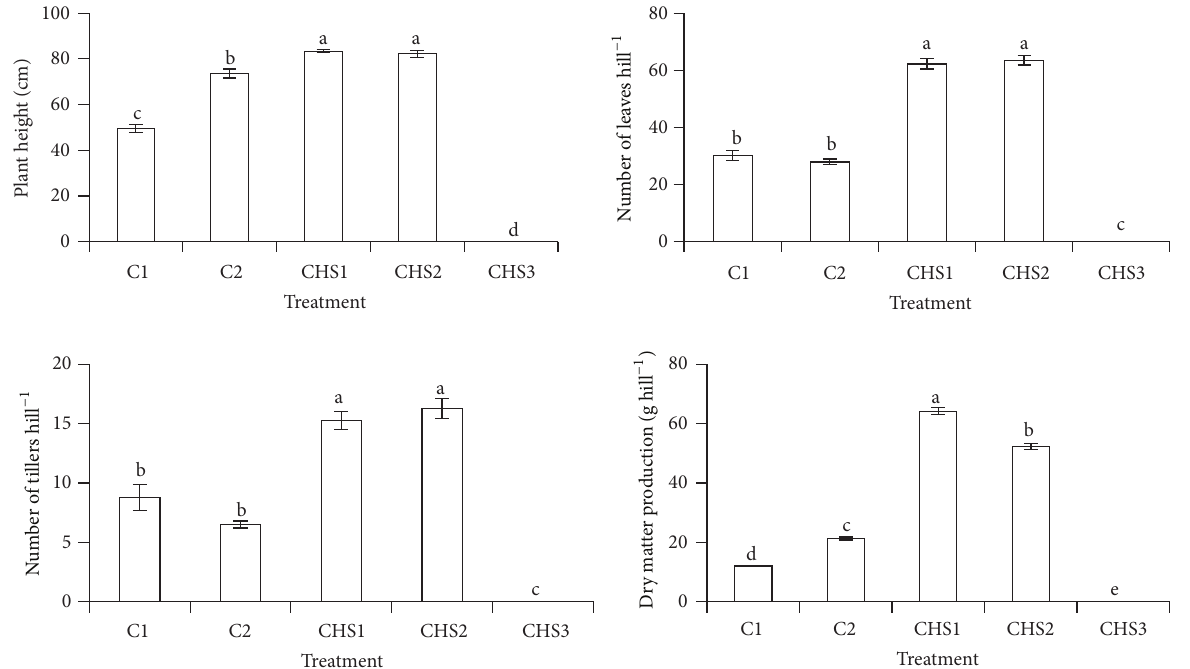
Figure 4: Treatments (C1: soil alone, C2: soil + complete fertilization, CHS1: soil + complete fertilization + 20 g rice straw compost + 2 g sawdust ash, CHS2: soil + complete fertilization + 40g rice straw compost + 4g sawdust ash, and CHS3: soil + complete fertilization + 60 g rice straw compost + 6g sawdust ash) effect on plant height, number of leaves, tillers, and dry matter production of rice plant at 90 days after seeding. Different alphabets indicate significant difference between means using Tukey’s test at 𝑃 ≤ 0.05 . The error bars are the ± standard error of